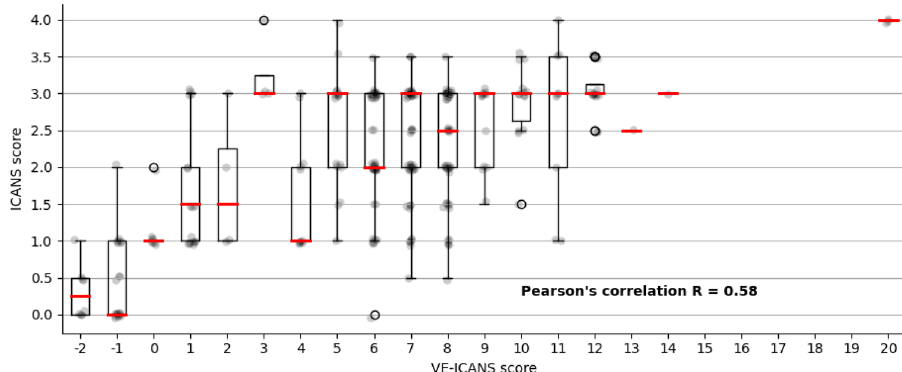
Figure 2. Distribution of predicted scores (VE-ICANS) versus ICANS scores. The VE-ICANS scores are highly correlated with ICANS (avg. value of 0.58 across 1000 bootstraps with 95% CI 0.47–0.66). For each level of VE-ICANS (x-axis), a box plot shows the distribution of ICANS scores (y-axis). The box plots use traditional ranges with 50% inside the box and whiskers extending to points within 1.5 × the inter-quartile range. Means at each level are shown in red. The semitransparent points (grey) show the value of VE-ICANS for each datapoint in the dataset with darker areas indicating a greater concentration of points.